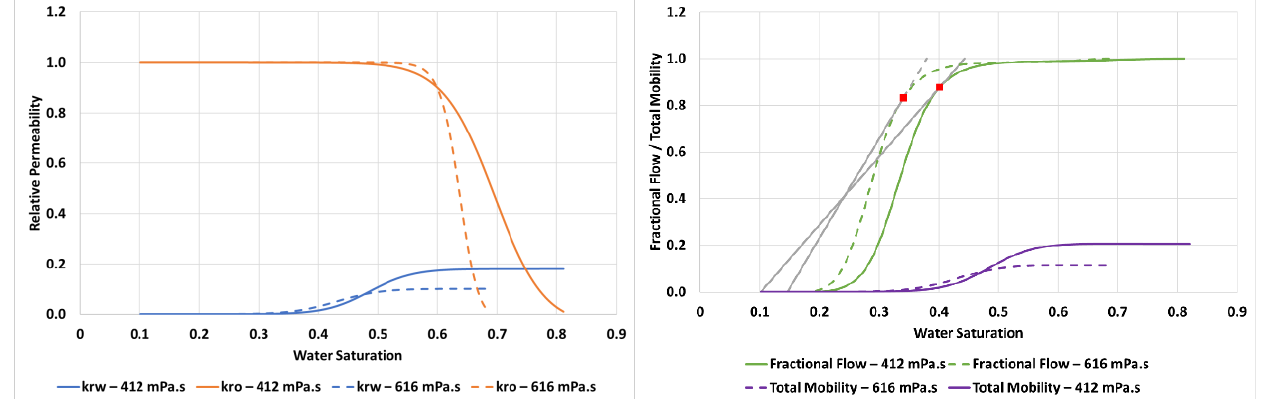
Table 5. LET input parameters for the 412 mPa.s and 616 mPa.s oil displacement case.